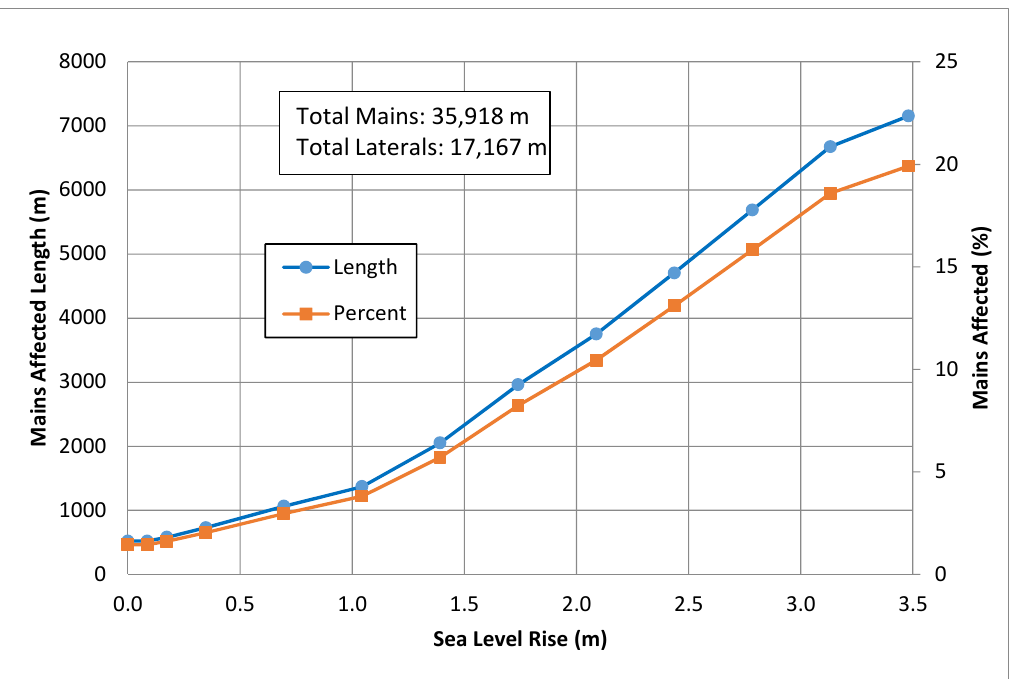
Figure 6. Length and percentage of sewer mains affected by sea level rise (SLR) in Downtown Honolulu.